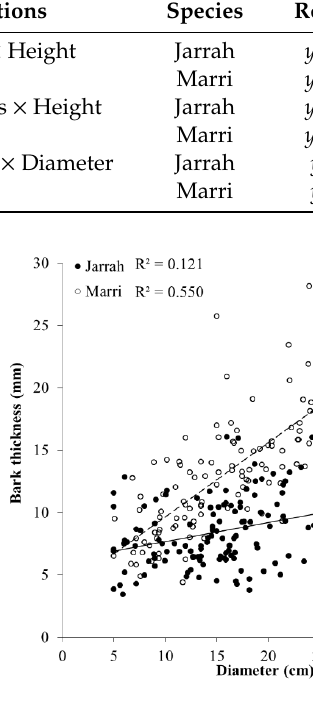
Figure 1. Relationships between bark thickness (mm) and diameter (cm) for 1 m sections up to 13 m in height for jarrah ( Eucalyptus marginata ●) ( n = 142) and marri ( Corymbia calophylla ○ ) ( n = 114) trees infested by the Australian eucalyptus longhorned borer Phoracantha semipunctata in the Northern Jarrah Forest (NJF), Southwestern